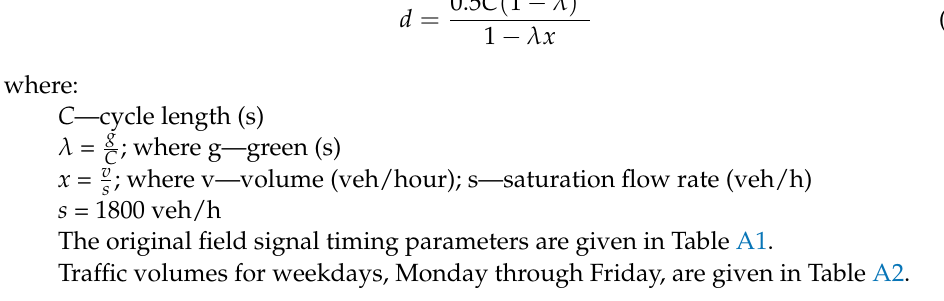
Table A1. Signal timing parameters. Average Green for Eastbound and Cycle Length [s] Westbound Approach [s] Off-peak 180 82.5 AM peak 180 85.5